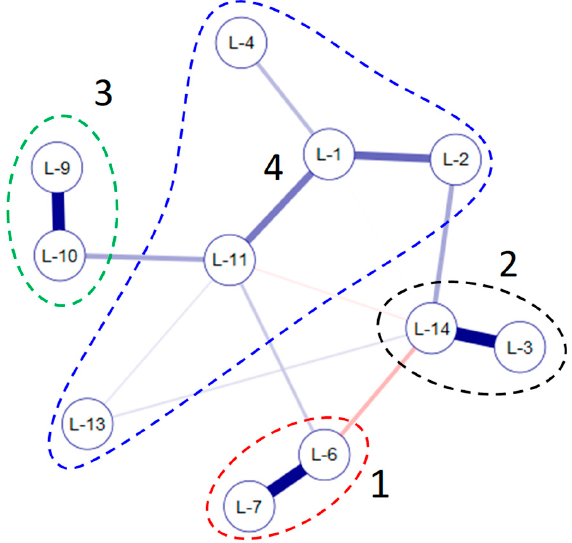
Figure 4. JASP Network plot for the 11 studied small water bodies ( p < 0.5), based on the bo tt om of Appendix Table A4.